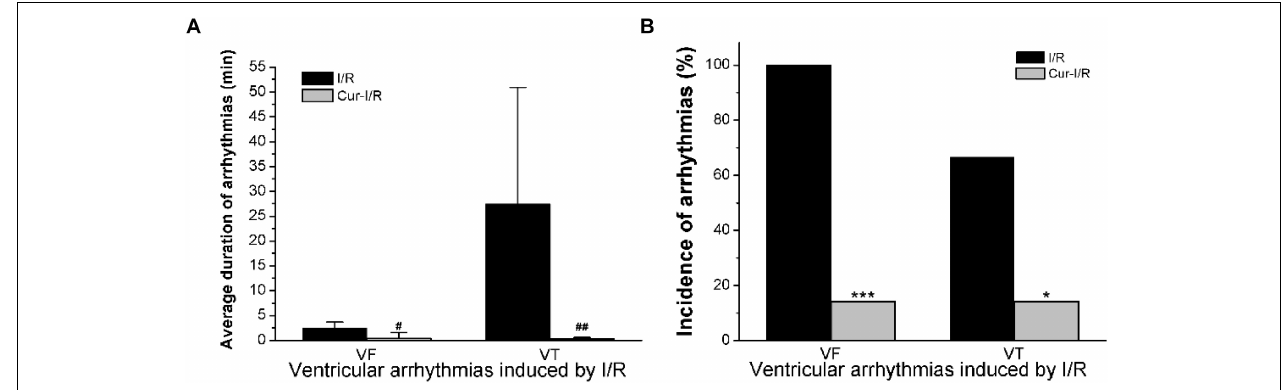
FIGURE 8 | The histogram of I/R experiments results. (A) The comparison of average duration of ventricular fibrillation (VF) and ventricular tachycardia (VT) after reperfusion in the two groups ( # P < 0.05, ## P < 0.01 vs. I/R group). (B) The comparison of the incidence of VF and VT in the two groups (* P < 0.05, *** P < 0.001 vs. I/R